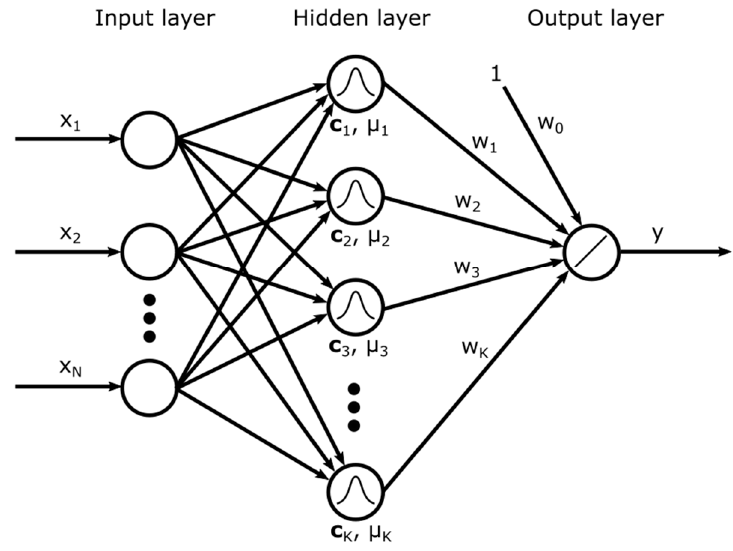
Figure 4. A general structure of an RBFNN.